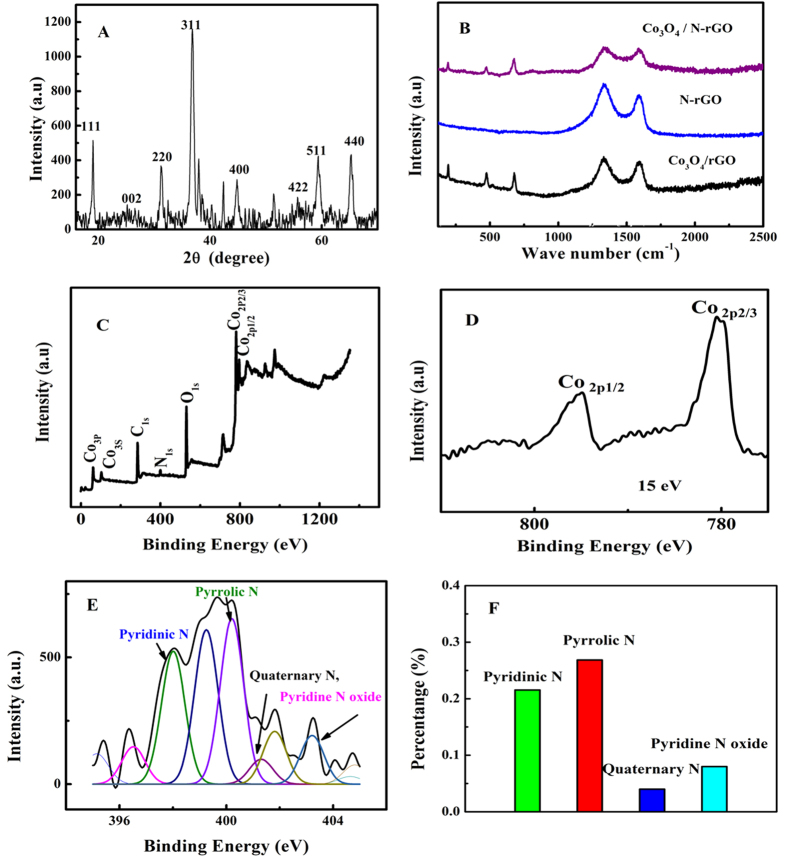
XRD spectrum of Co3O4/N-rGO (A) and Raman spectra of Co3O4/N-rGO, N-rGO and Co3O4/rGO (B); The XPS full spectrum of Co3O4/N-rGO (C) and high resolution Co2p spectra of Co3O4/N-rGO (D); High-resolution N1s XPS spectra of Co3O4/N-rGO (E); The percentage of three nitrogen species in Co3O4/N-rGO (E).